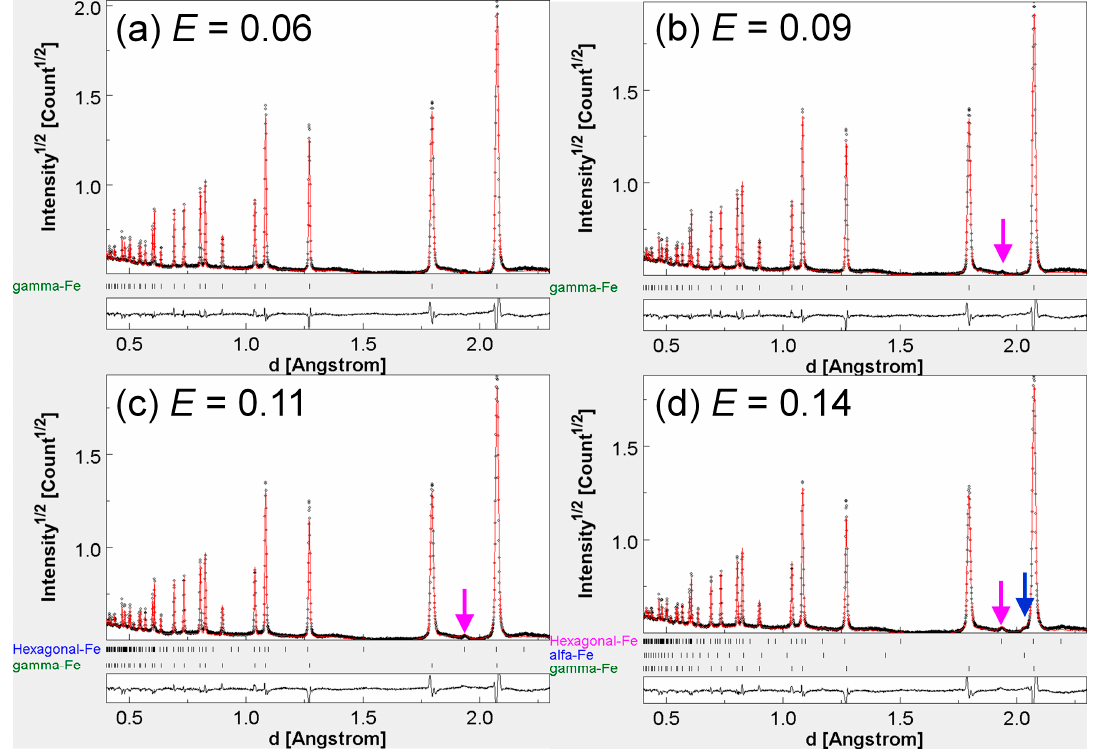
Figure 4. Average diffraction patterns observed in Bank 81 at different strains. The pink and blue arrows indicate 110 ε and 110 α diffraction peaks, respectively.